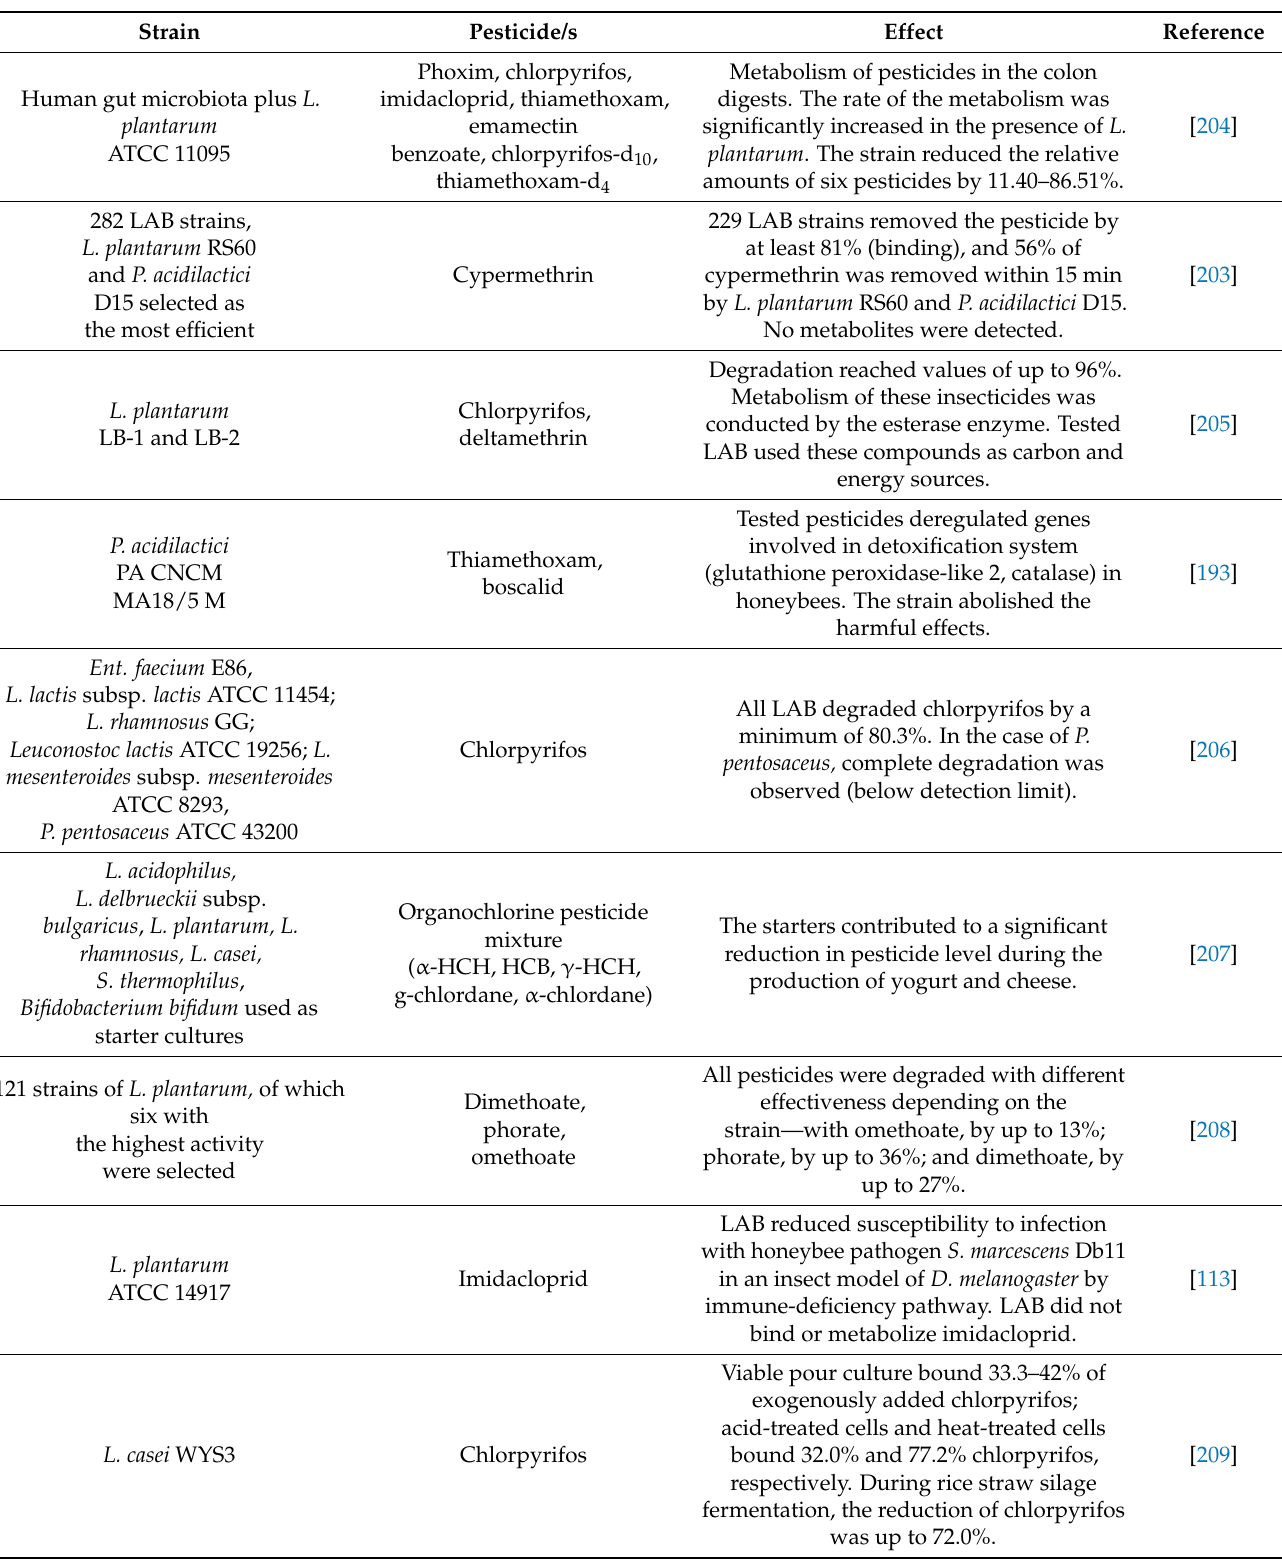
Table 1. Summarized effects of probiotics on pesticide mitigation, binding, degradation, metabolism, and toxicity in diverse